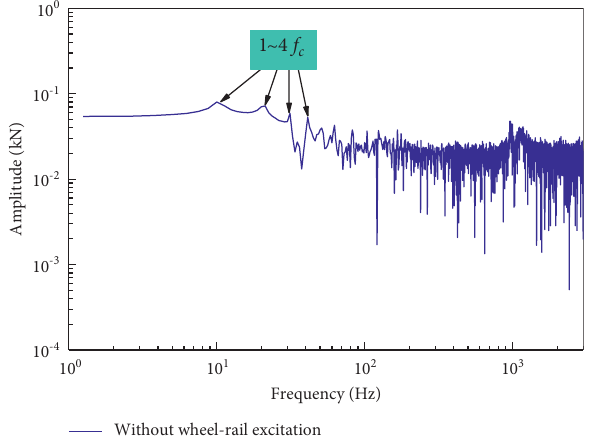
Figure 11: Contact load